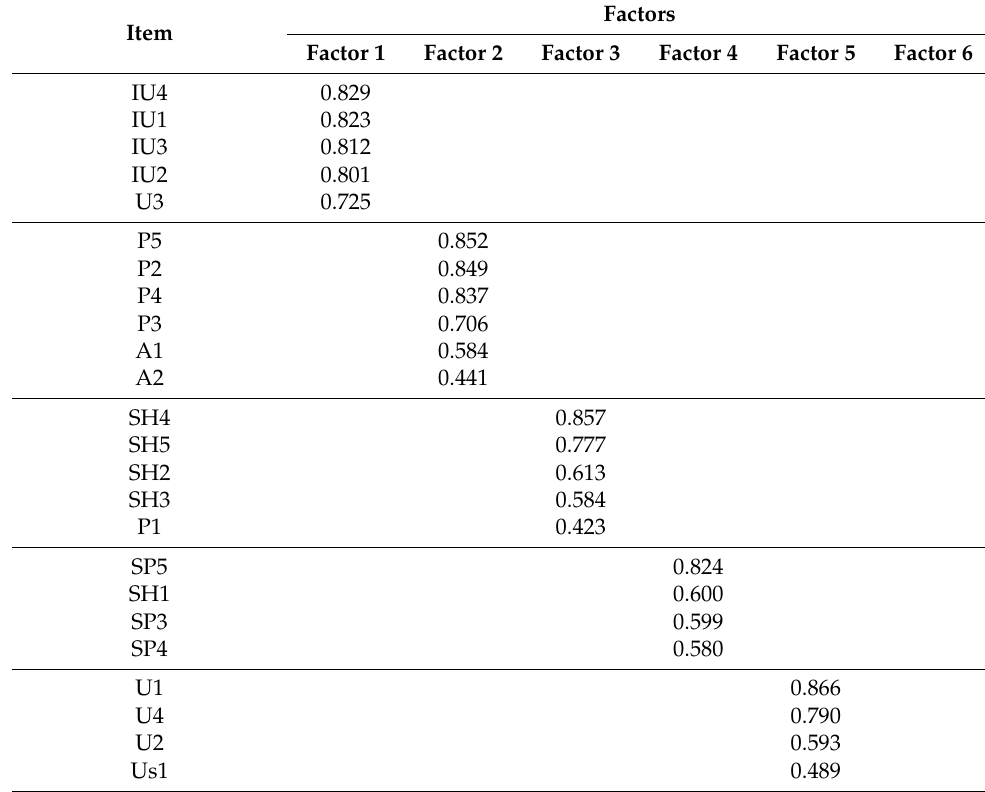
Table 4. Result of factor analysis for UX evaluation of VR fashion